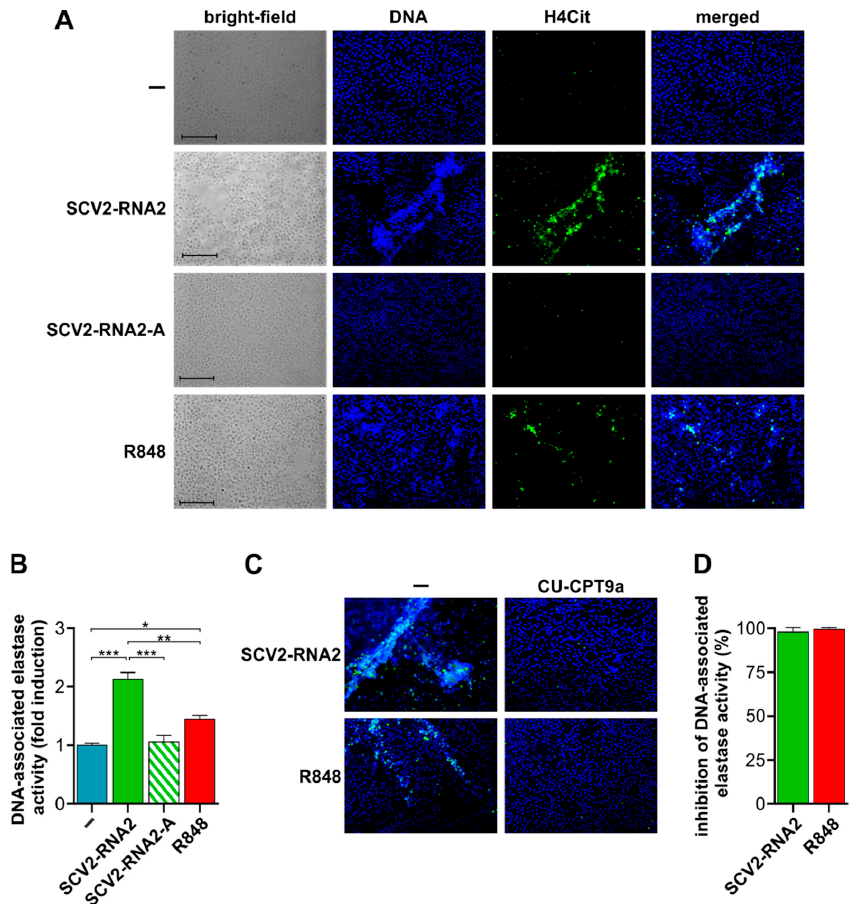
Figure 5. SCV2-RNA2 efficiently stimulates neutrophil extracellular trap (NET) formation which is blocked by TLR8 inhibition. Isolated neutrophils were left untreated (-) or stimulated with 10 μ g/mL SCV2-RNA2, 10 μ g/mL SCV2-RNA2-A, or 5 μ M R848 for one hour ( A ) and four hours ( B ). ( A ) NETs were identified, using fluorescence microscopy, by the co-localization of citrullinated histone-4 (H4Cit) stained in green (AF-488) and DNA stained in blue (Hoechst). Bright-field images are also shown. Scale bar: 100 μ m. ( B ) NETs were also quantified in cell supernatants by analyzing DNA-associated elastase activity after a limited DNase I digestion. Elastase activity associated with DNA was quantified by a fluorogenic elastase substrate and monitored with a fluorescent plate reader. Results are expressed as fold induction of elastase activity compared to unstimulated cells. * p < 0.05, NETs as identified in panel A . Scale bar: 100 μ m. Representative experiments out of three. ( D ) NETs were quantified in cell supernatants by analyzing DNA-associated elastase activity after a limited